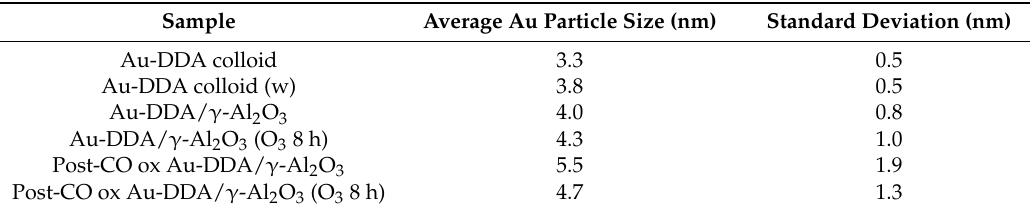
Table 1. Au particle size from TEM.